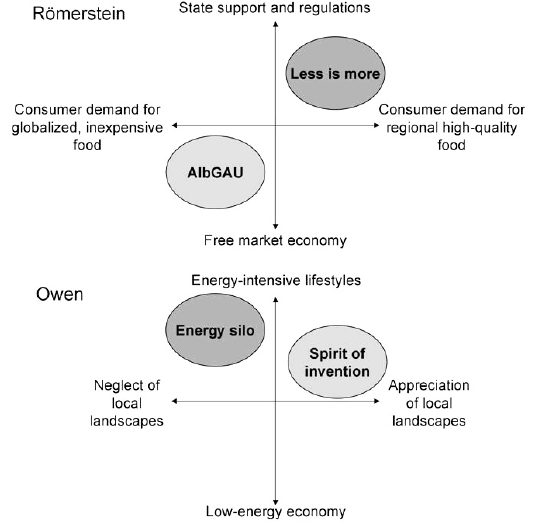
Fig. 8 . Key drivers of future landscape development in the four